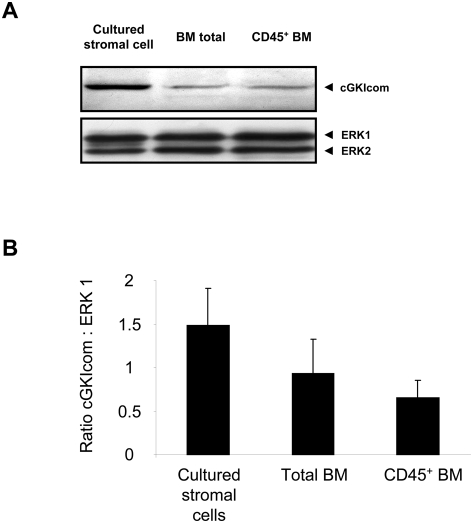
Expression of cGKI in the bone marrow.(A) Representative western blot of cultured bone marrow stromal cells, freshly isolated total bone marrow cells, and freshly isolated CD45+ bone marrow leukocytes using an antibody against cGKI (cGKIcom: detecting cGKIα and cGKIβ). ERK1/2 was used as loading control. (B) Quantification of the ratio cGKIcom : ERK1 protein expression in cultured stromal cells, total bone marrow, and CD45+ bone marrow in 129/Sv WT mice (n = 3 / group, p = n.s.).